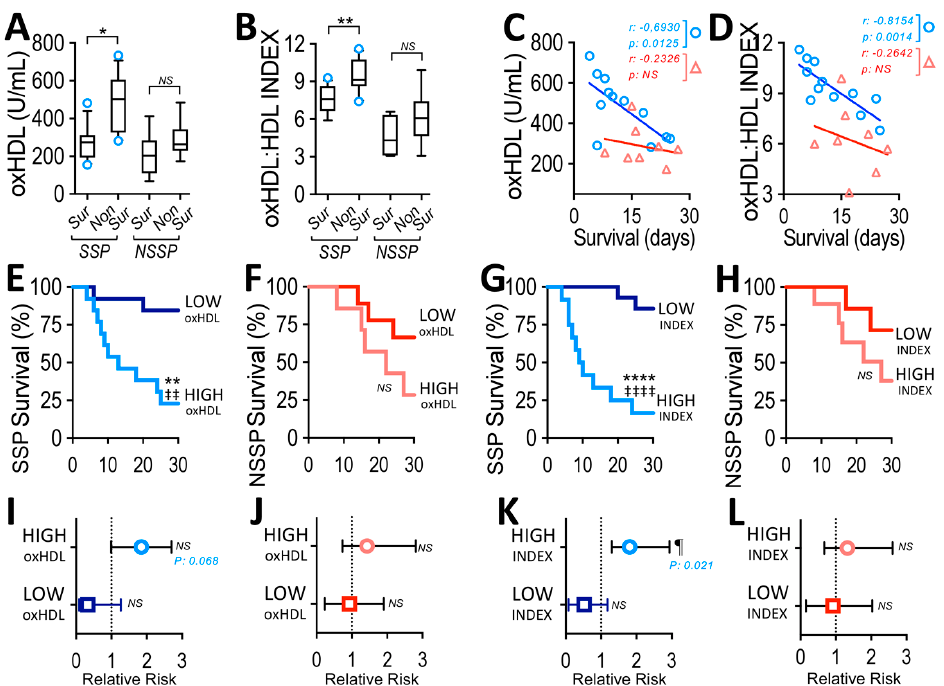
Figure 2. OxHDL plasma level and INDEX in surviving and non-surviving patients, survival time correlation, survival curve comparisons and relative risk of death analyses in SSP and NSSP. ( A , B ) Plasma level of oxHDL ( A ) and INDEX ( B ) in surviving and non-surviving SSP (blue circles) and NSSP (red triangles). Statistical differences were assessed with student’s t -test (Mann–Whitney) for SSP and NSSP. * p < 0.05, ** p < 0.01, NS: non-significant. Values are expressed as the median ± 10–90 percentile. ( C , D ) Correlation analyses between oxHDL ( B ) and INDEX ( C ) with days of permanence at ICU for non-surviving patients within a 30-day time frame in SSP (blue circle) and NSSP (red triangle) groups ( r = − 0.6930; p = 0.0125 and r = − 0.2326; p = 0.5793, respectively, for C, and r = − 0.8154; p = 0.0012 and r = − 0.2642; p = 0.5271, respectively, for ( D )). Survival (Kaplan–Meier) curves within a 30-day time frame for SSP ( E , G ) and NSSP ( F , H ) comparing high- and low-oxHDL ( E , F ) or comparing high- and low-INDEX ( G , H ). ** p = 0.01 (log-rank (Mantel–Cox) test) ‡‡, p = 0.01 (Gehan–Breslow–Wilcoxon test) when comparing high-oxHDL versus low-oxHDL groups. **** p < 0.0001 (log-rank (Mantel– Cox) test). ‡‡‡‡, p < 0.0001 (Gehan–Breslow–Wilcoxon test) when comparing high-INDEX